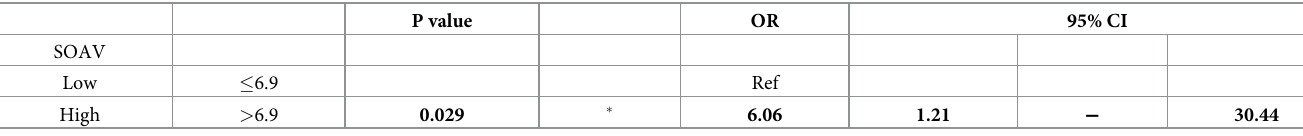
Table 3. Logistic regression analysis of SOAV and occurrence of BRSs. SOAV